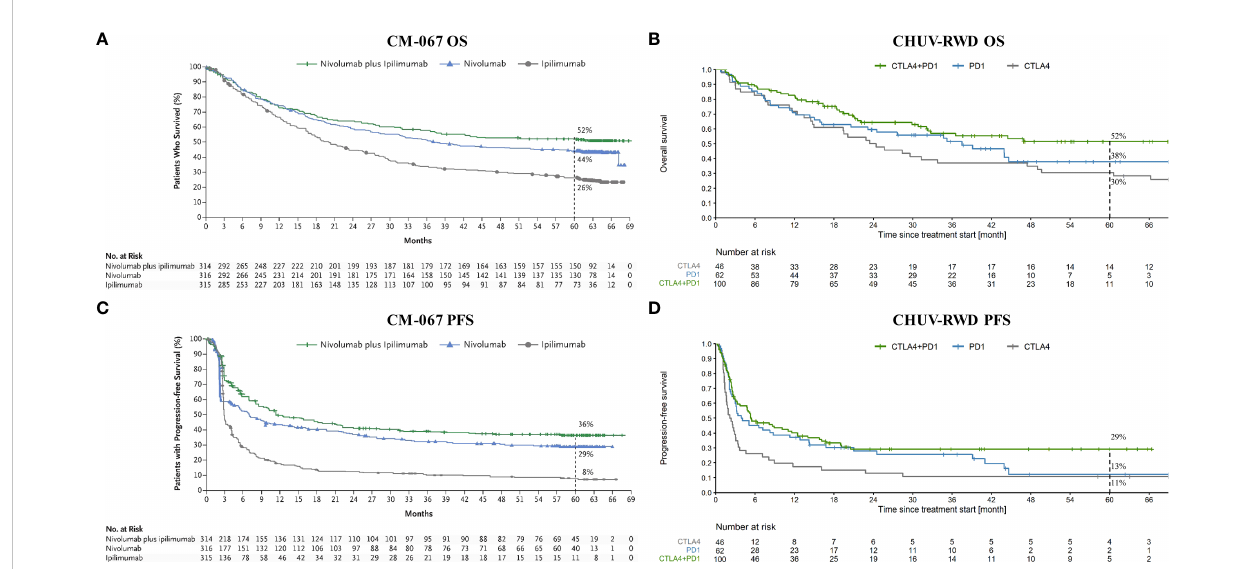
FIGURE 3 OS and PFS from Checkmate 067 (CM-067) and CHUV-RWD melanoma patients. Left panels (A) and (C) show the OS and PFS respectively from CM-067 and right panels (B) and (D) , OS and PFS for the CHUV-RWD. The left panels from CM-067 have been reproduced with permission from Larkin et al., 2019, NEJM (16). Dashed lines at 60 month indicate the percent of patients left in each